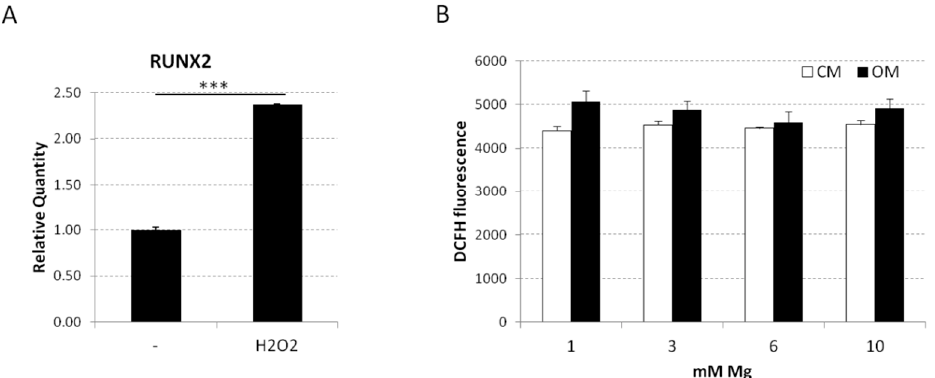
Figure 7. ( A ) The bMSCs were treated for 30 min with H 2 O 2 (50 µ M) and then cultured for four days in culture medium (CM). RUNX2 expression was analyzed using QRT-PCR. The p -value was calculated vs. untreated cells; *** p < 0.001. ( B ) Reactive oxygen species (ROS) accumulation was quantified using 2 (cid:48) -7 (cid:48) -dichlorofluorescein diacetate (DCFH, Sigma-Aldrich). Cells were seeded into black-bottomed 96-well plates (Greiner Bio-One) and cultured in 1, 3, 6, and 10 mM Mg, added or not with the osteogenic cocktail for 24 h. Then, cells were washed with phosphate-buffered saline (PBS) and exposed to DCFH (20 µ M). The rate of intracellular oxidative stress was evaluated by monitoring the emission at 529 nm of the DCFH dye using a GloMax ® -Multi Detection System (Promega, Madison, WI, USA). Three independent experiments were performed. Data are shown as means ± standard